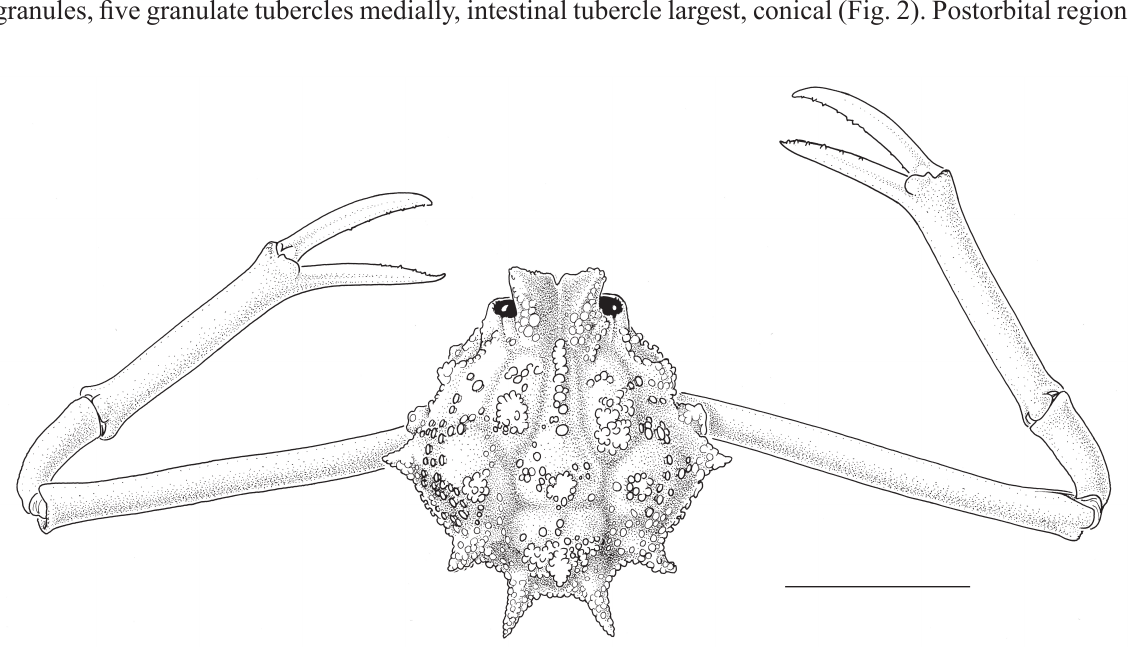
Fig. 2. Praebebalia fungifera sp. nov., holotype, ♂ ( 8.8 mm) (MNHN-IU-2013-5996). Carapace and chelipeds, dorsal view. Papua New